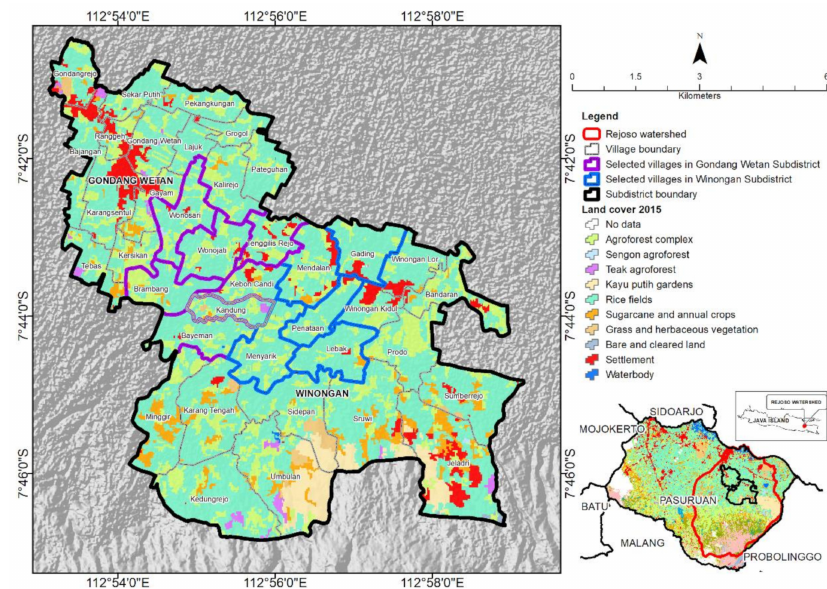
Figure 2. Delineation of the study